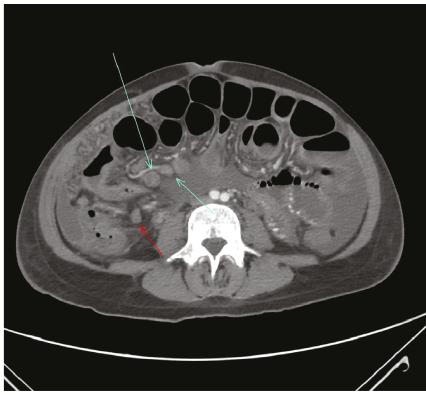
Figure 4: An additional CT image of the abdomen demonstrates mesenteric adenopathy (green and red